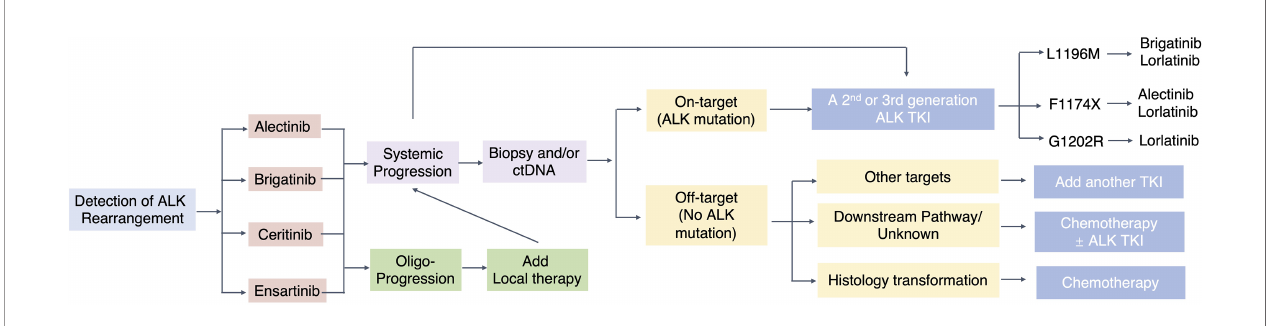
FIGURE 2 | Treatment strategy for